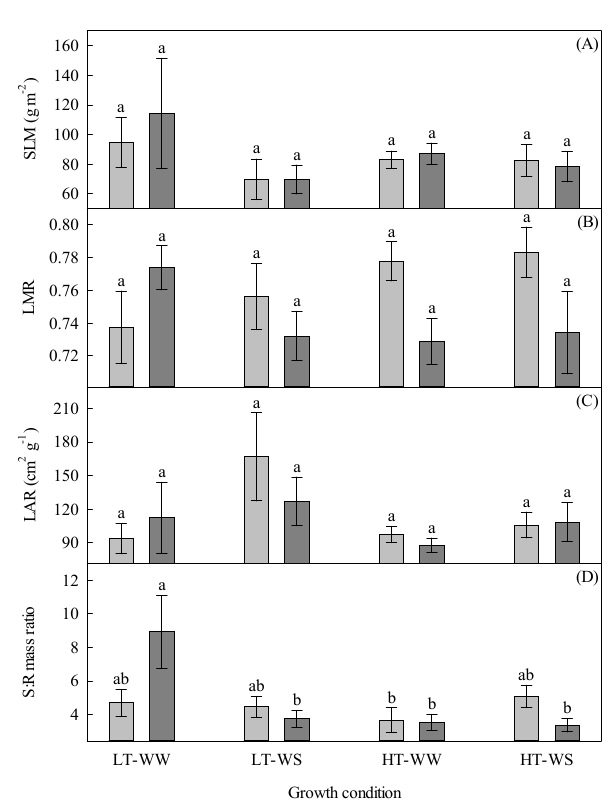
Figure 3. Growth indices of 33-day-old tomato plants grown under eight experimental conditions including two temperature regimes, two watering regimes, and two abscisic acid concentration applications after 12 days of initial germination and growth in growth chambers with lower temperature, watering to field capacity, and without abscisic acid application. ( A ) Specific leaf mass (SLM), ( B ) leaf mass ratio (LMR), ( C ) leaf area ratio (LAR), and ( D ) shoot to root ratio (S:R). LT, lower temperature; HT, higher temperature; WW, well-watered; WS, water stressed; light gray, no abscisic acid; dark gray, abscisic acid. Data are the means ± SE of 71 samples from three experiments. Bars with different letters above them are significantly different according to Scheffé’s multiple comparison procedure at the 5% confidence level.